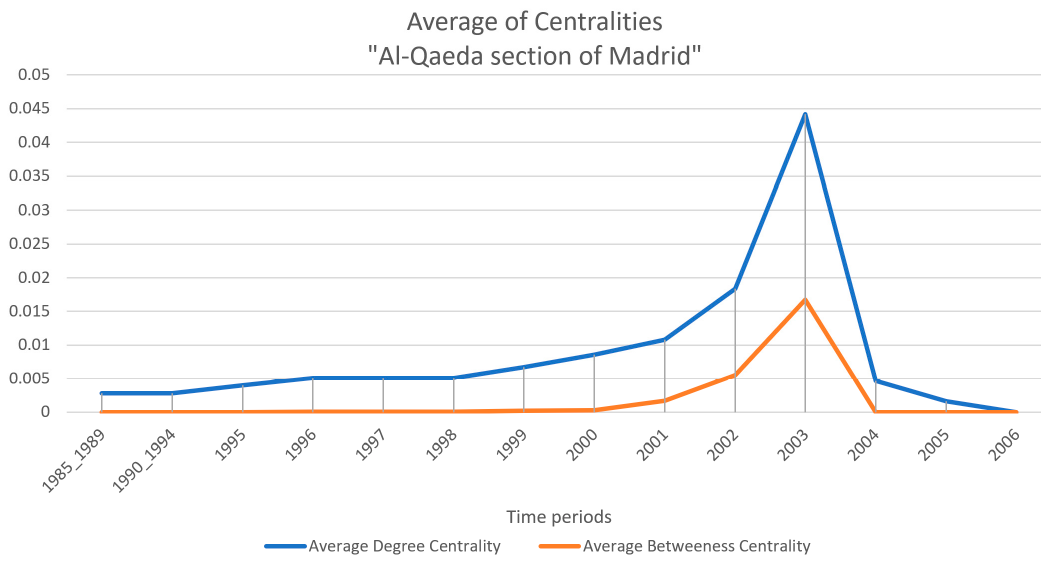
Figure 15. Temporal development of average degree centrality and average betweenness centrality for the “Al-Qaeda section of Madrid”. Both indices increase, reach a maximum in 2003 and then decrease rapidly.